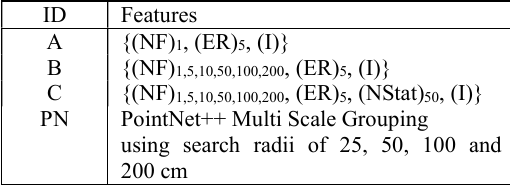
Table 3. Different sets of features used in the experiment